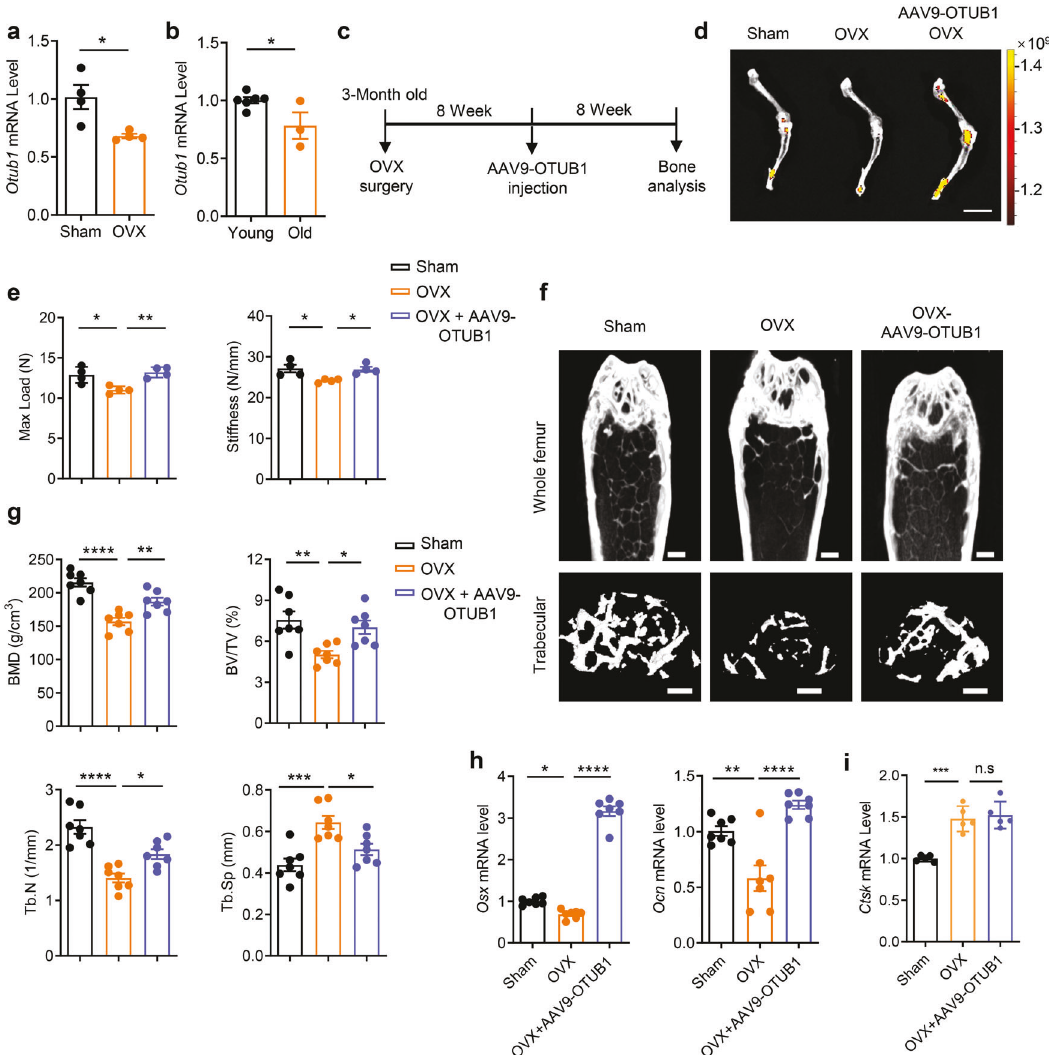
Fig. 6 OTUB1 overexpression alleviates osteoporosis in OVX mice. a Quantitative RT-PCR analysis of Otub1 mRNA levels in BMSCs derived from Sham-operated (Sham) and ovariectomy (OVX) mice. n = 4 per group. b Quantitative RT-PCR analysis of Otub1 mRNA levels in young (2 months, n = 6) and old (2 years, n = 3) mice bone tissues. c Schematic diagram illustrating the experimental design of AAV9-OTUB1 treatment in OVX mice. Scale bars, 1 cm. d AAV9-OTUB1 expression in the hindlimb monitored by IVIS-100 optical imaging 8 weeks post injection. e Quanti fi cation of maximal loading (Max load) and stiffness of humeral diaphysis from Sham, OVX, and OVX-AAV9-OTUB1 groups. n = 4 per groups. f Representative micro-CT images of whole femoral (top) and trabecular (bottom) bones from Sham, OVX, and OVX-AAV9-OTUB1 group. n = 7 per group. Scale bar, 0.5 mm. g micro-CT measurements of BMD, BV/TV, Tb.N, and Tb.Sp in femurs from Sham, OVX, and OVX-AAV9-OTUB1 groups. n = 7 per group. h Quantitative RT-PCR analysis of osteogenesis gene mRNA levels in femurs from Sham, OVX, and OVX-AAV9-OTUB1 groups. n = 7 per group. i Quantitative RT-PCR analysis of osteoclastogenesis gene mRNA levels in femurs from Sham, OVX, and OVX-AAV9- OTUB1 groups. n = 5 per group. *p < 0.05, **p < 0.01, ***p < 0.001, ****p < 0.0001, n.s., not signi fi cant. All data are shown as the mean ±